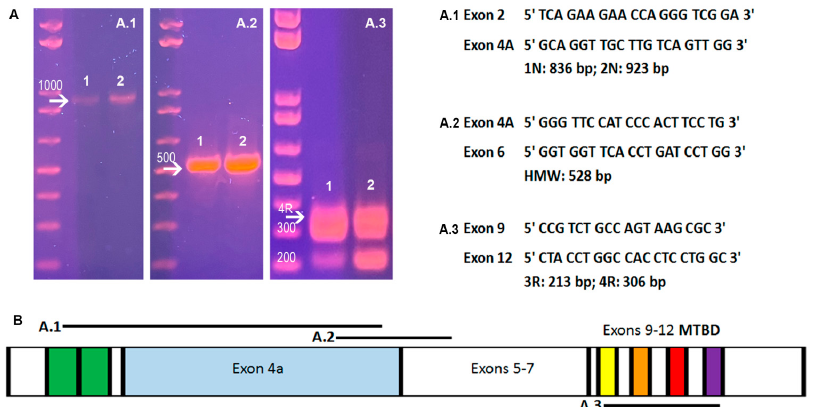
(Figure 3A,B) underscoring their potential value as a model system for studying Big tau regulation and function.